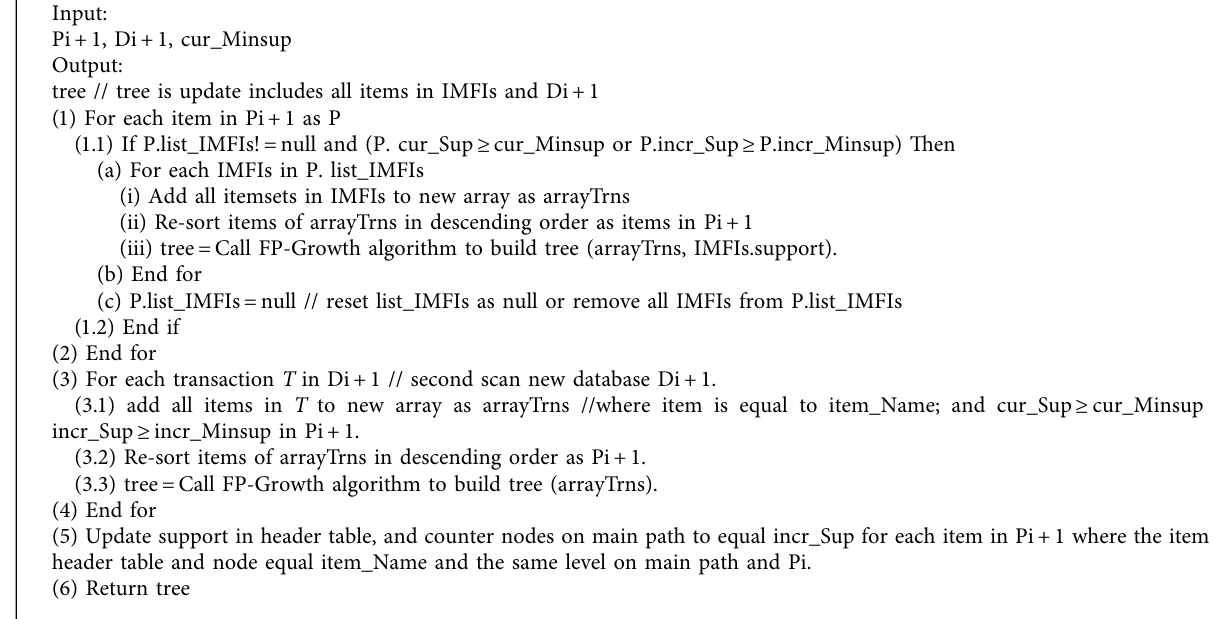
A LGORITHM 3: Created tree algorithm.